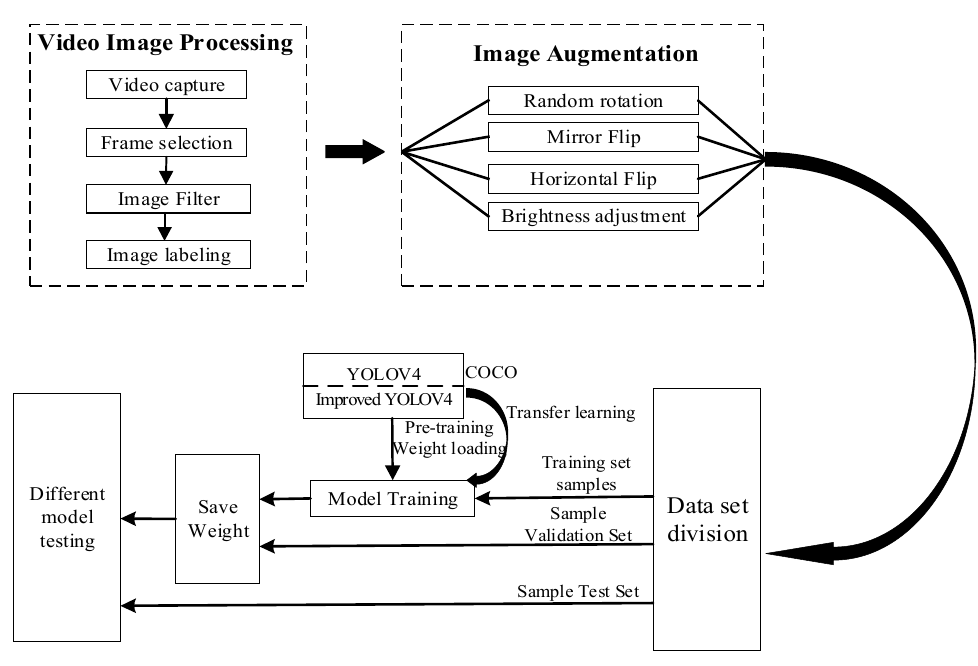
Figure 2. Flow chart of goat-face recognition.